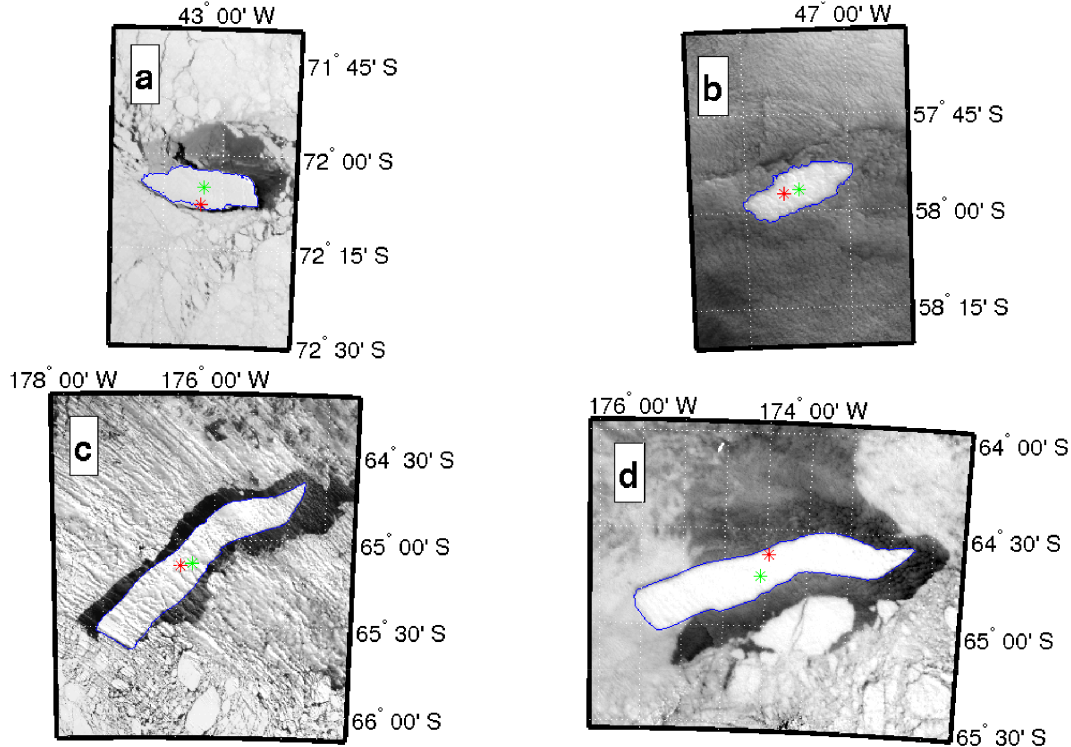
Figure 3. Example of B17a ( a , b ) and C19a ( c , d ) area estimate using MODIS images. The blue lines represent the iceberg perimeter and the red and green crosses represent the NIC and MODIS iceberg’s positions,